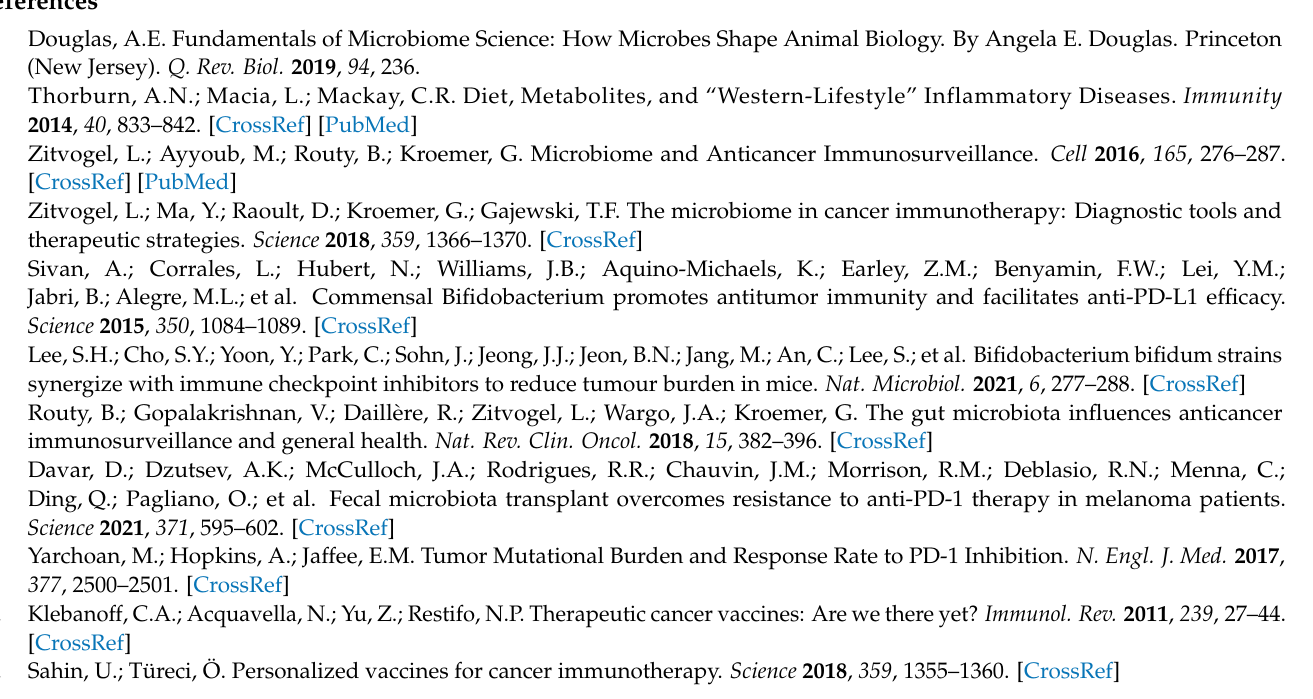
Figure S2: MDS analysis on all 16s rRNA samples colored by timepoints and conditions’ centroids., Figure S3: Differentially abundant species between T3 and T7., Figure S4: Differentially abundant species between T3 and